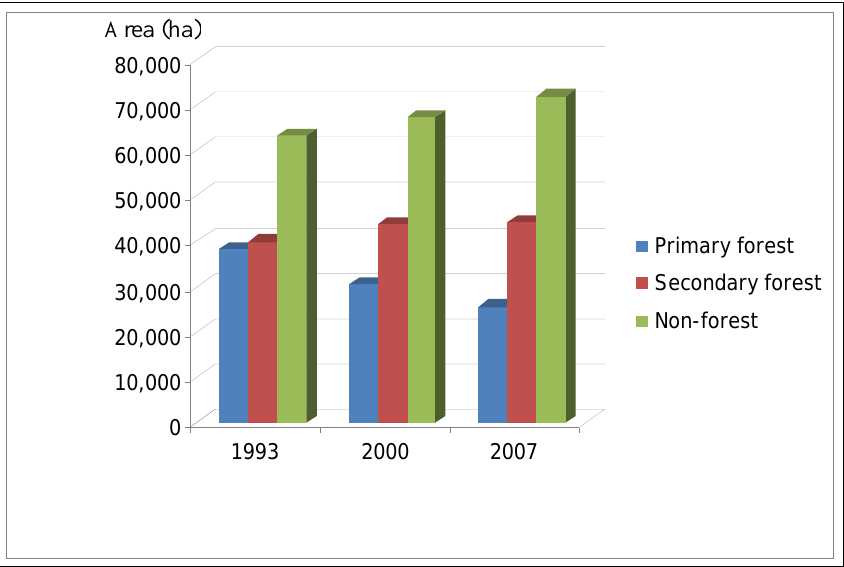
Figure 7. Areas of primary forest, secondary forest and